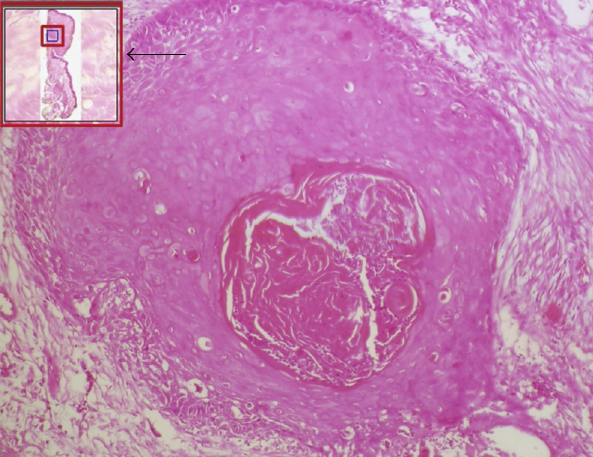
Figure 11: User interface in Zoomify. One can zoom in and out at high resolution. Note an enlarged view of small boxed area within a navigator (large red box with arrow). Note the red boxes in the figure. Follow them for an easy